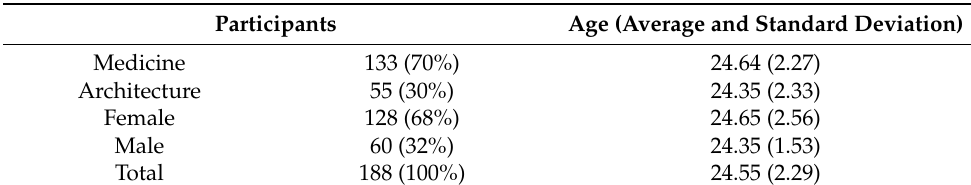
Table 1. Characteristics of participants.